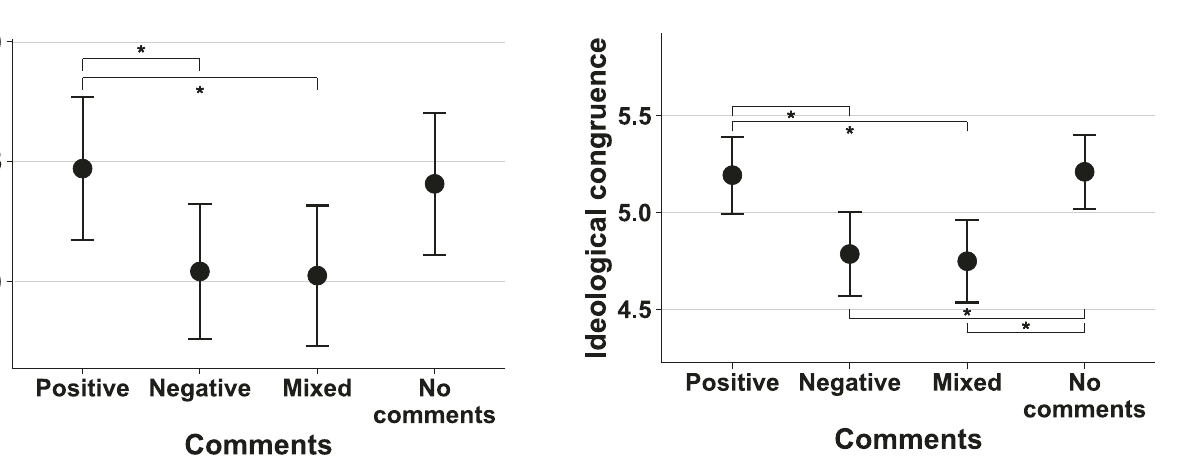
Fig. 6 Main effect of comment sentiment on ideological congruence . Error bars represent 95% CIs, signi fi cant differences ( p < 0.011) are indicated